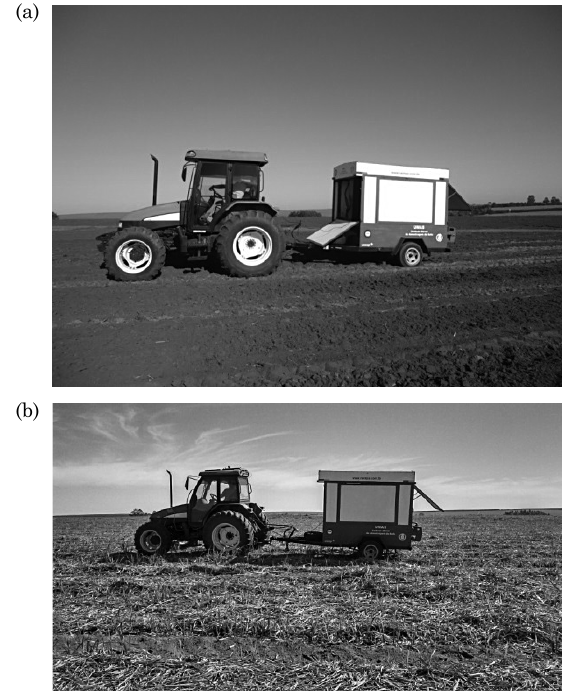
figure 2. evaluation after soil tillage (a) and after sugarcane harvest after 15 months (b) with the mobile soil sampling